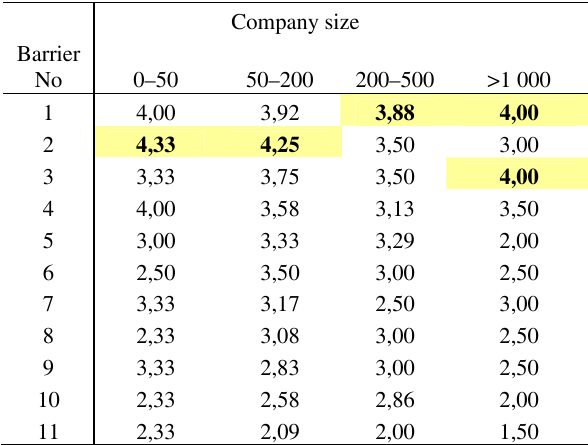
Table 8. Importance of perceived barriers with respect to